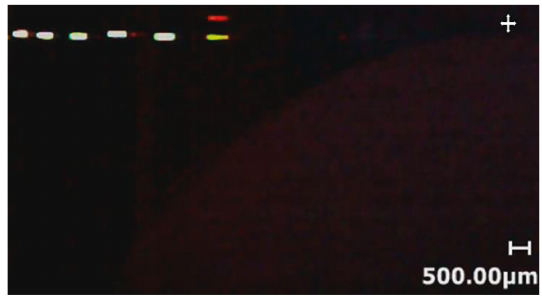
Figure 6: The spark flight path at speed of